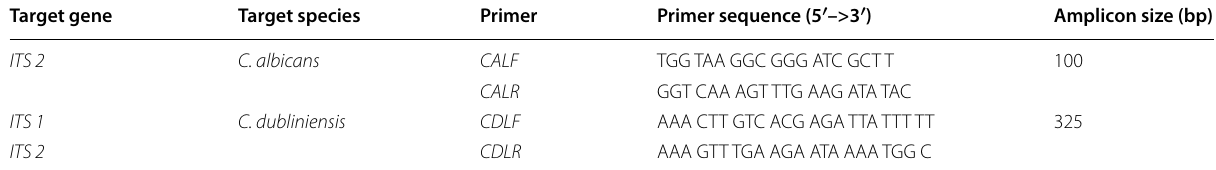
Table 1 The primer sequences used for amplification of C. albicans and C. dubliniensis for duplex PCR Target